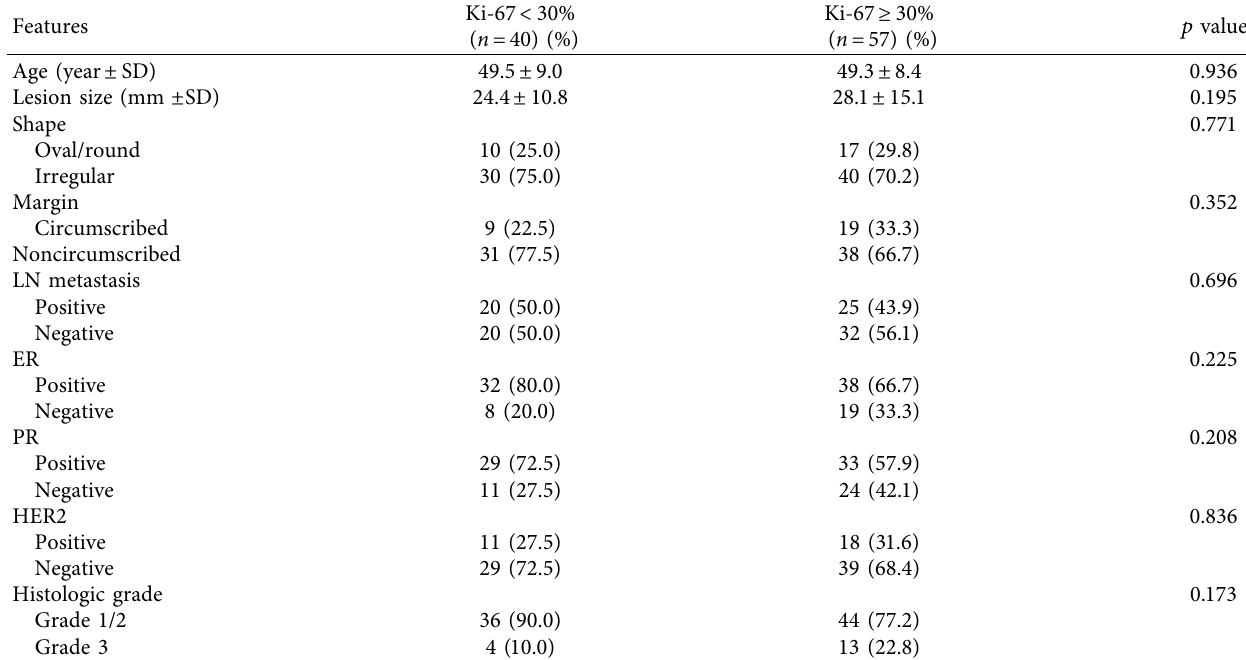
Table 2: Clinicopathological and DCE-MRI features of patients with IDC and low ( < 30%) or high ( ≥ 30%) Ki-67 proliferation.